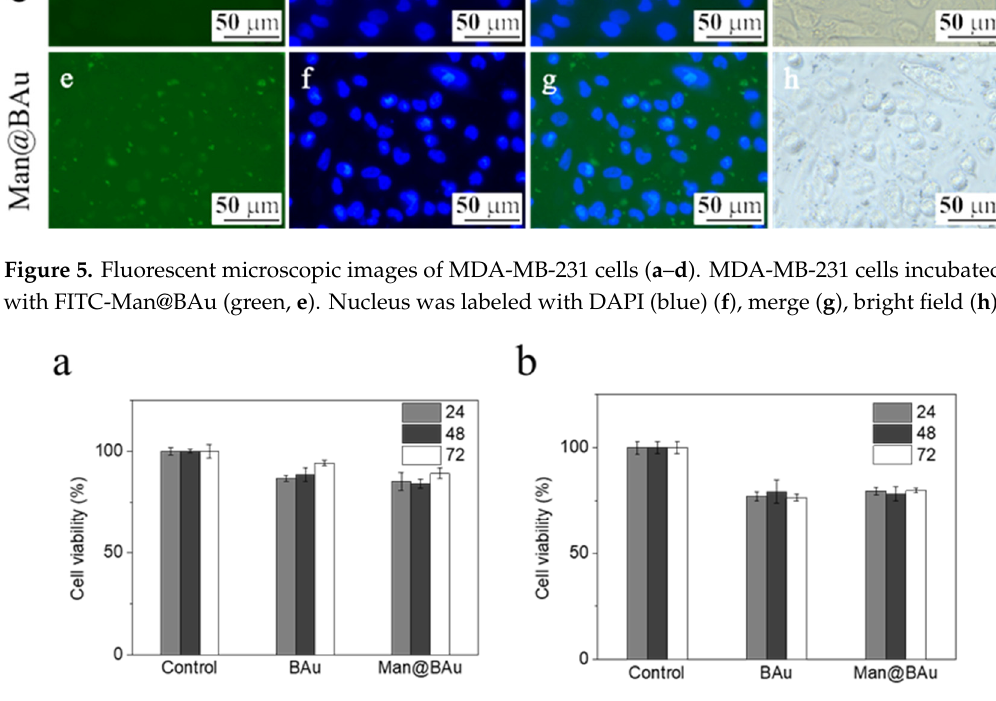
Figure 6. BAu or Man@BAu of ( a ) 0.05 mM and ( b ) 0.1 mM cultured with MDA-MB-231 cell for 24, 48, 72 hours, respectively, to test for cytotoxicity by MTT assay.